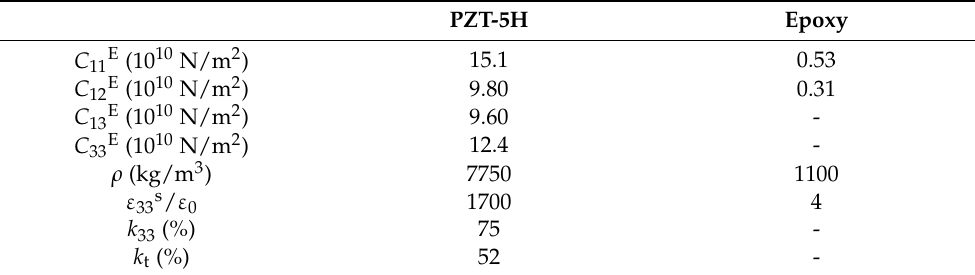
Table 2. Material properties of PZT-5H and Epo-Tek 301 epoxy for 2-2 composite design.